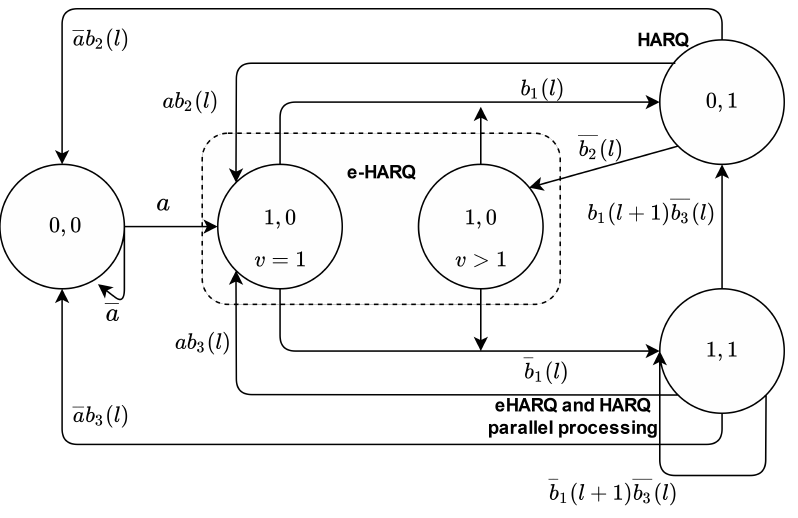
Figure 3. The graph of transition probabilities, taking into account only the major